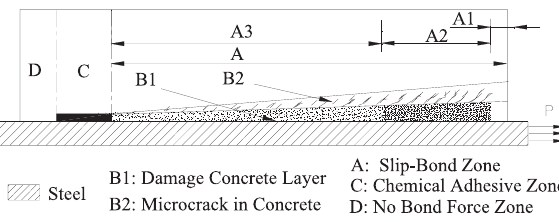
Fig. 1. Distribution of interfacial bond stress.